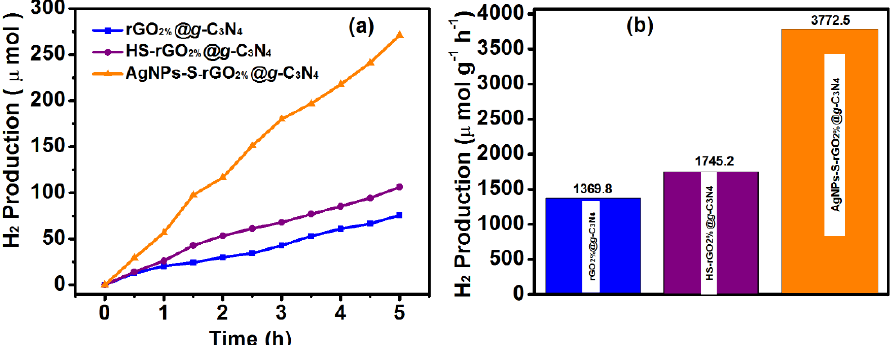
Figure 10. ( a ) Hydrogen production and ( b ) rate of hydrogen production per hour under the same